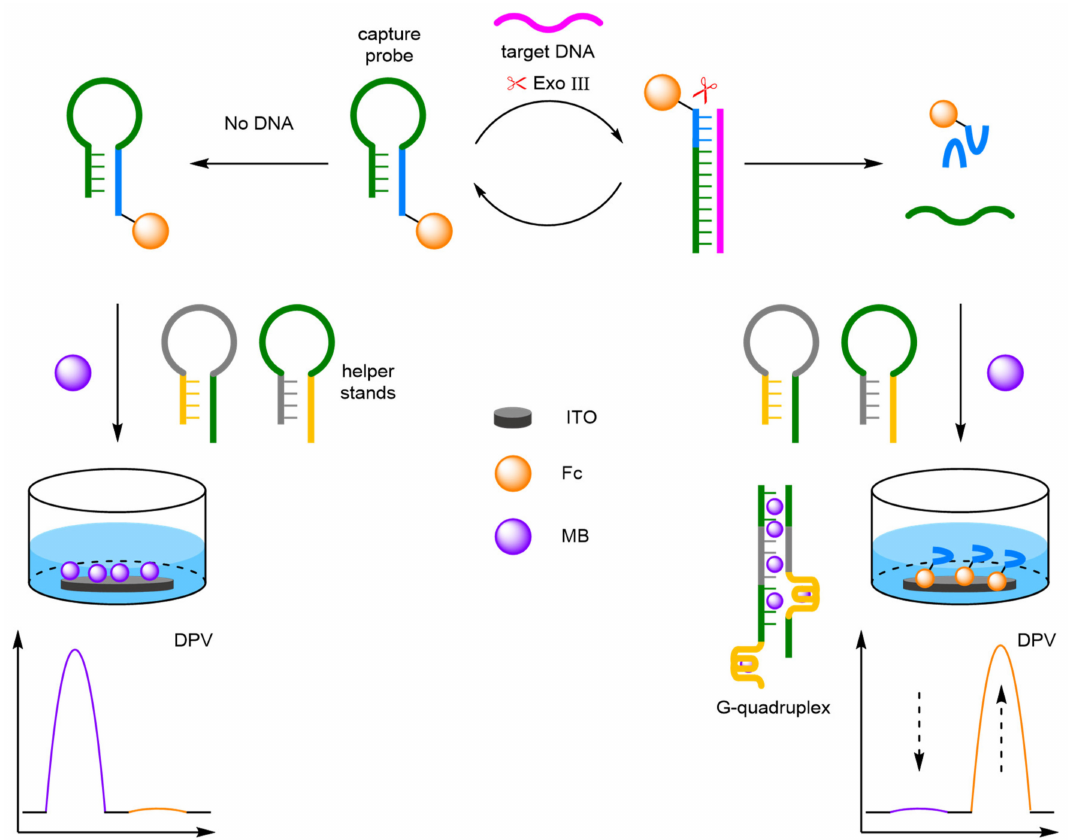
Figure 46. Schematic representation of diffusivity and intercalation-based unmodified